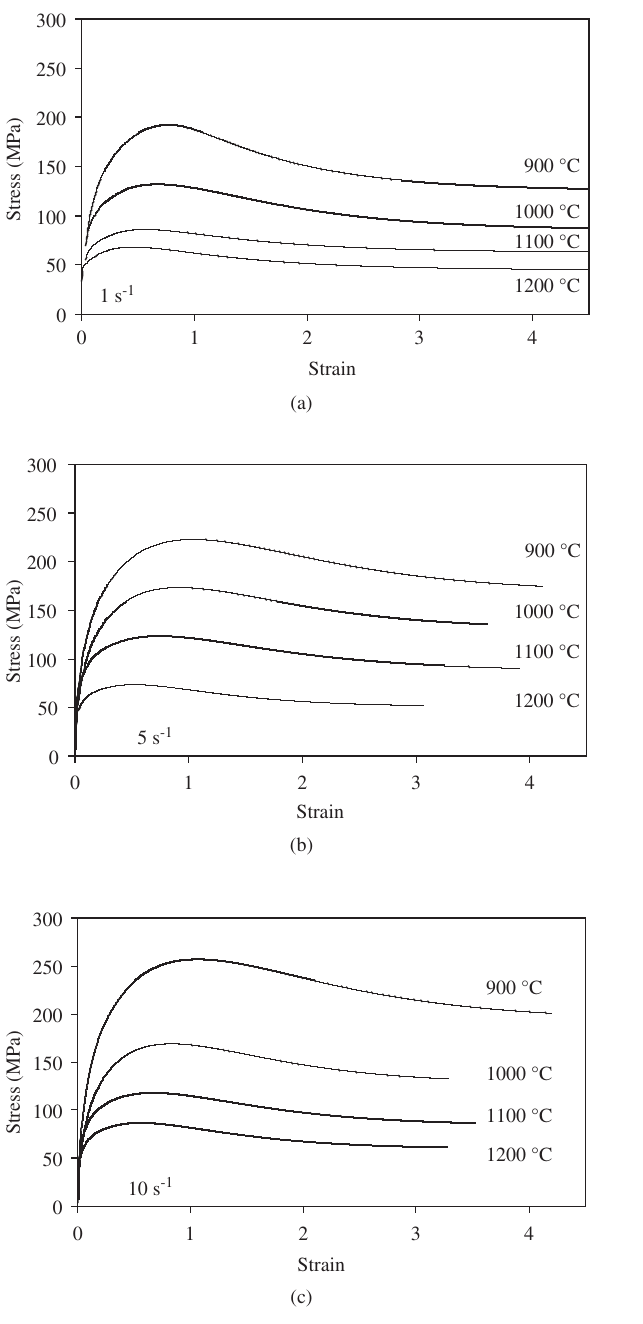
Figure 2. Dependence of the work-hardening rate ( θ ) on the applied stress for the flow curves described in Figure